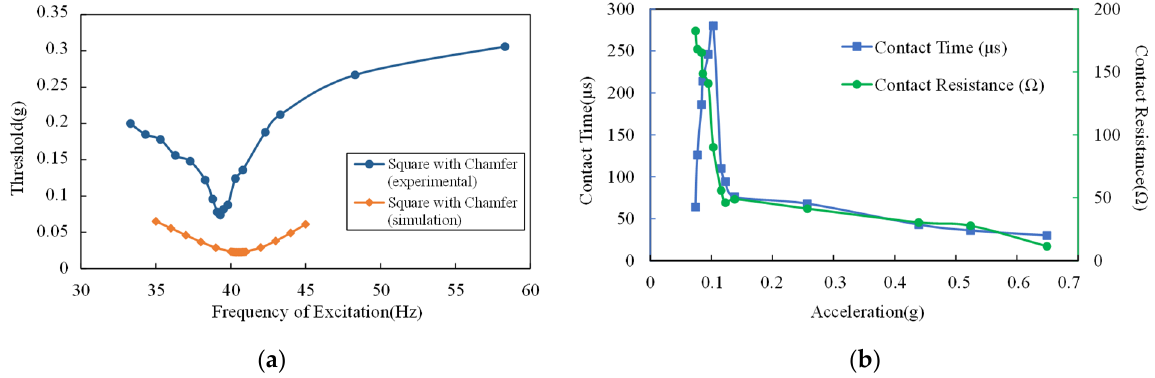
Figure 14. ( a ) Comparison of the simulation result and the experimental result of the acceleration threshold versus the excitation frequency; ( b ) experimental results of the contact time and the contact resistance versus the excitation acceleration.